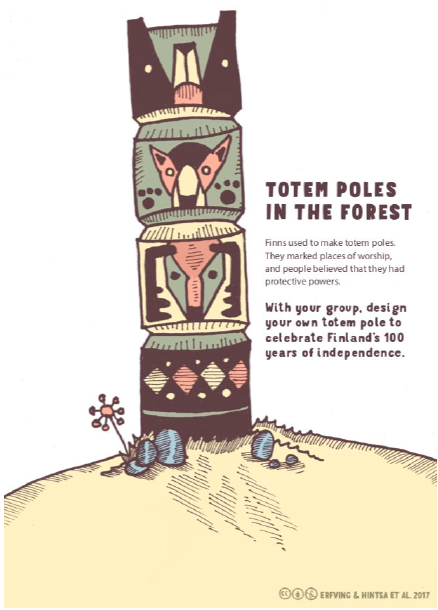
Figure 1. Example from the Whisper of the Spirit literature.